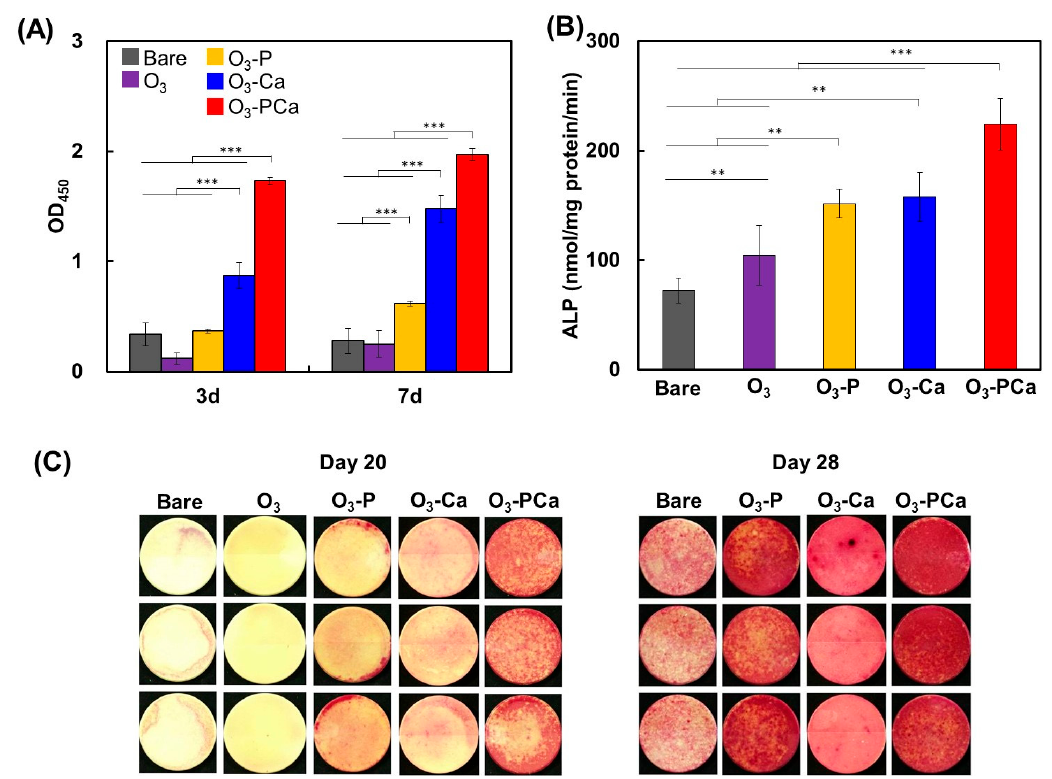
Figure 5. Mesenchymal stem cell responses to samples. ( A ) Cell proliferation ( n = 4), ( B ) ALP activity at 14 days ( n = 4), ( C ) bone-like nodule formation at 20 and 28 days ( n = 3). Data are the mean ± standard derivation (** p < 0.01, *** p < 0.001). Bare: untreated PEEK, O 3 : ozone-gas-treated PEEK, O 3 -P: phosphate-immobilized PEEK, O 3 -Ca: calcium-immobilized PEEK, O 3 -PCa: phosphate and calcium co-immobilized PEEK.